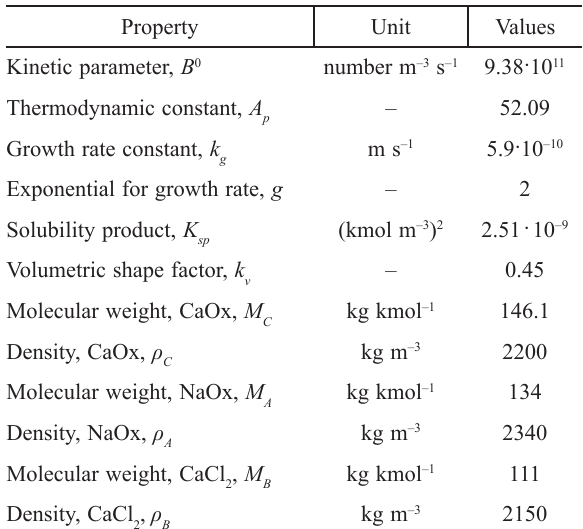
Table 1 – Kinetic parameters and physical properties used in simulations with PBM for single feed semi-batch precipitation of calcium oxalate